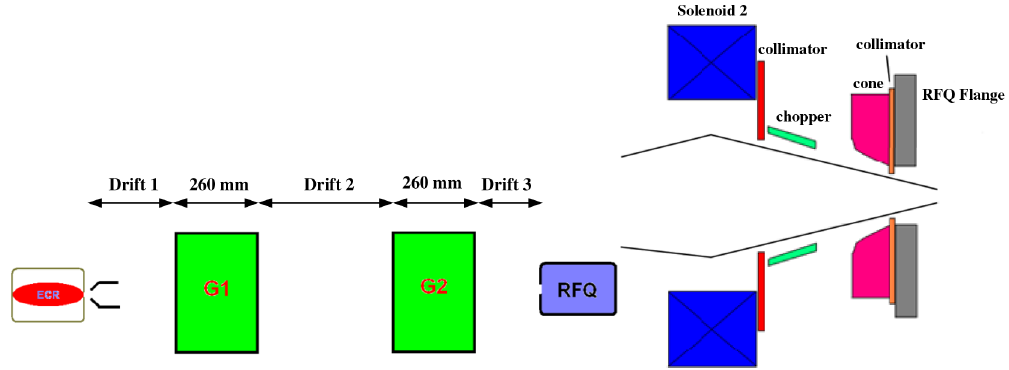
(right).FIG. 3. The schematic figure of the LEBT (left) and chopper (right). G1 and G2 are for Glaser magnetic